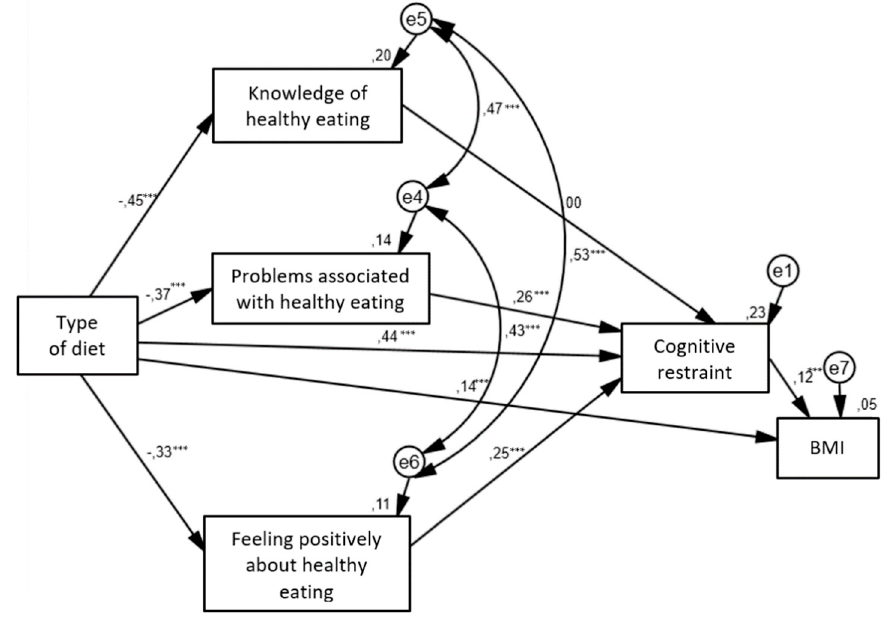
Figure 2. Structural equation model in adult population.